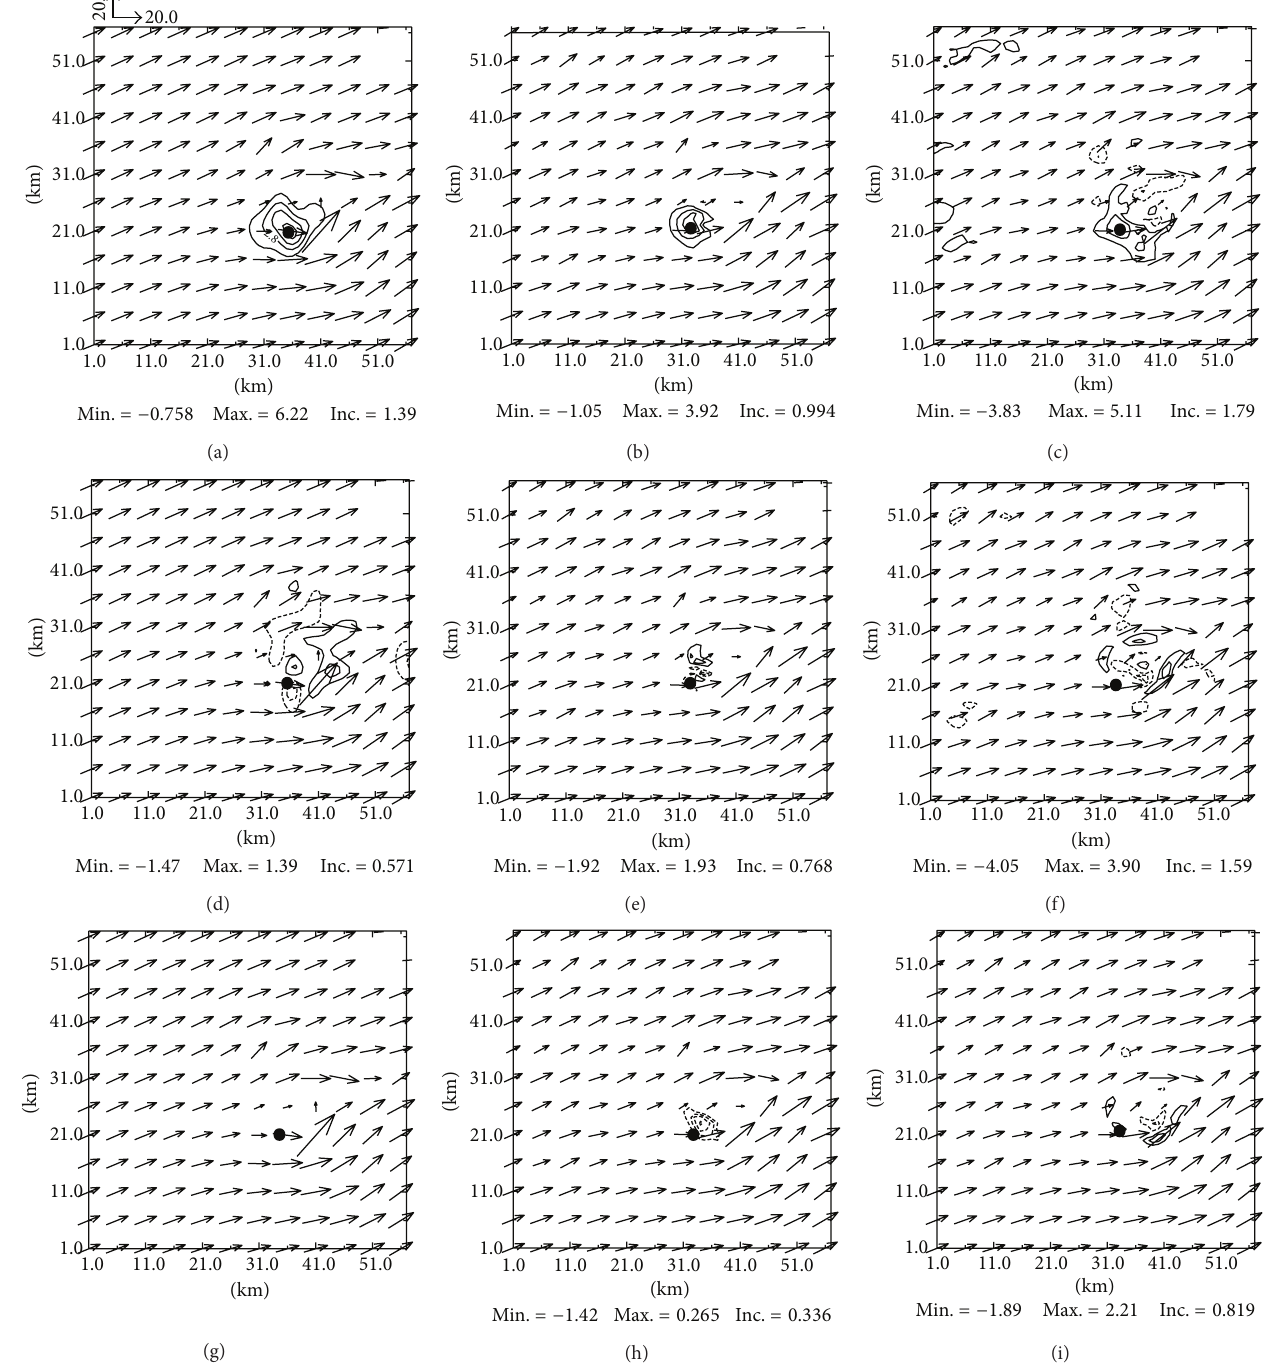
Figure 2: Wind vectors: 𝑢 -component increment by using (a) 3DVAR, (b) EnKF, and (c) hybrid 3DVAR-EnKF, 𝑤 -component increment by using (d) 3DVAR, (e) EnKF, and (f) hybrid 3DVAR-EnKF, and potential temperature increment by using (g) 3DVAR, (h) EnKF, and (i) hybrid 3DVAR-EnKF by assimilating a single radial velocity at the black